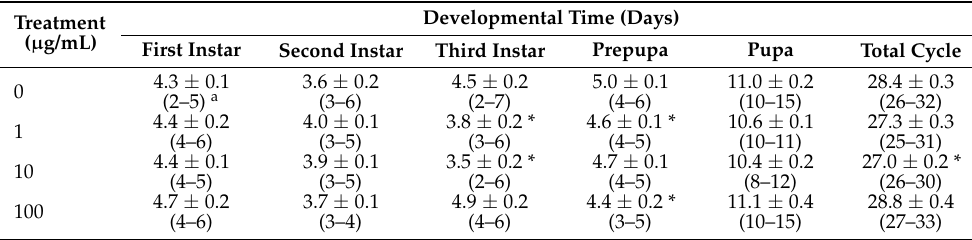
Table 2. Duration (days) of each phase in the life cycle of C. claveri exposed to C. nardus EO. Treatment ( µ g/mL)